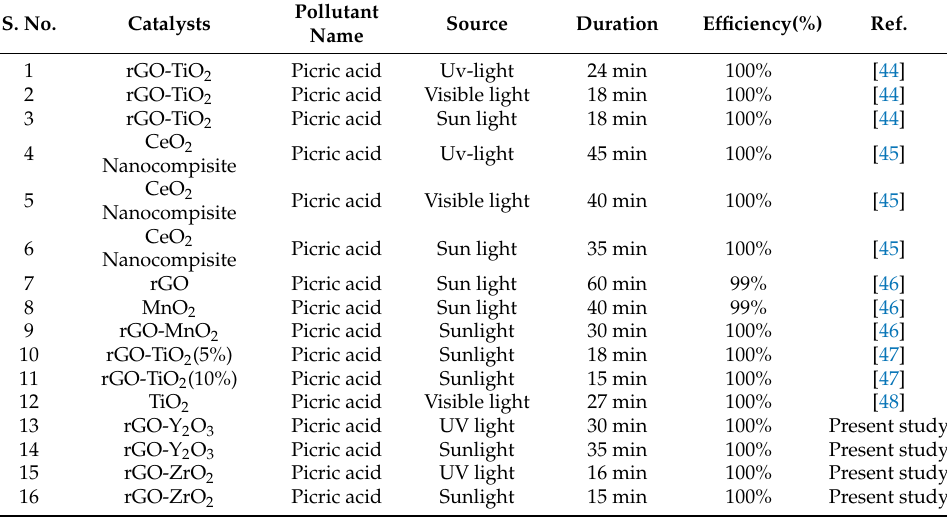
Table 1. Comparison studies of recently reported literature on photocatalytic